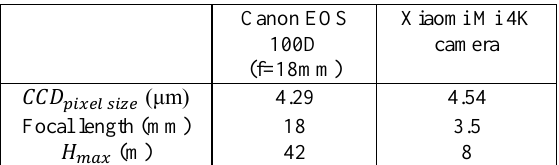
Table 1. Flight height (or distance from the target to sensor) values for 𝐺𝑆𝐷 =